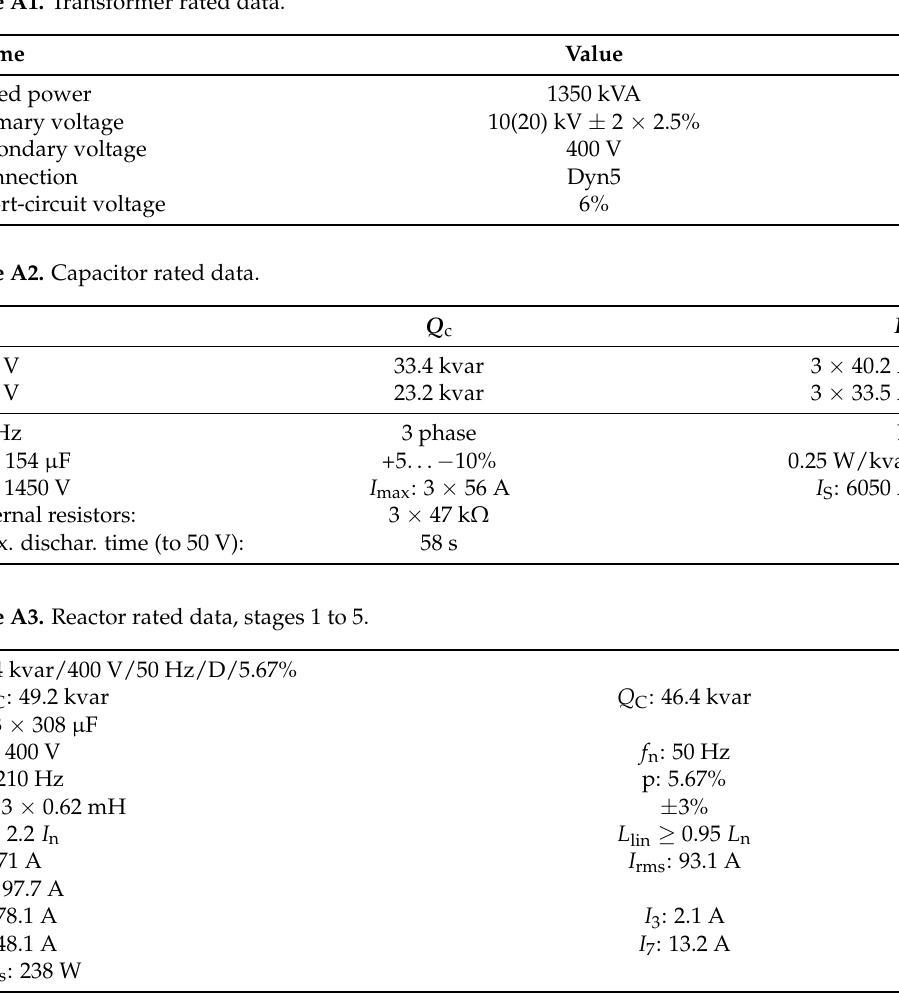
Table A1. Transformer rated data.